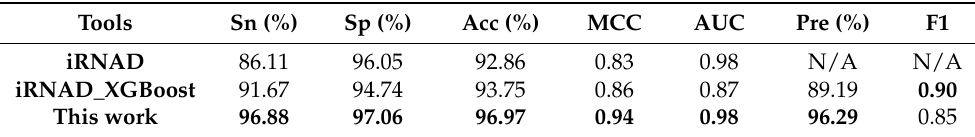
Table 4. Comparisons between iRNAD, iRNAD_XGBoost, and our current model to identify D modification sites in independent tests.